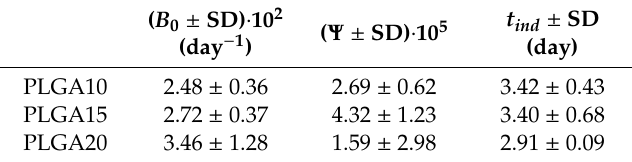
Table 2. Best-fit parameters of the model (reported in Equation (19)) used to simulate propagation kinetics of the degradation front. Standard deviations (SD) of the parameters were calculated over three